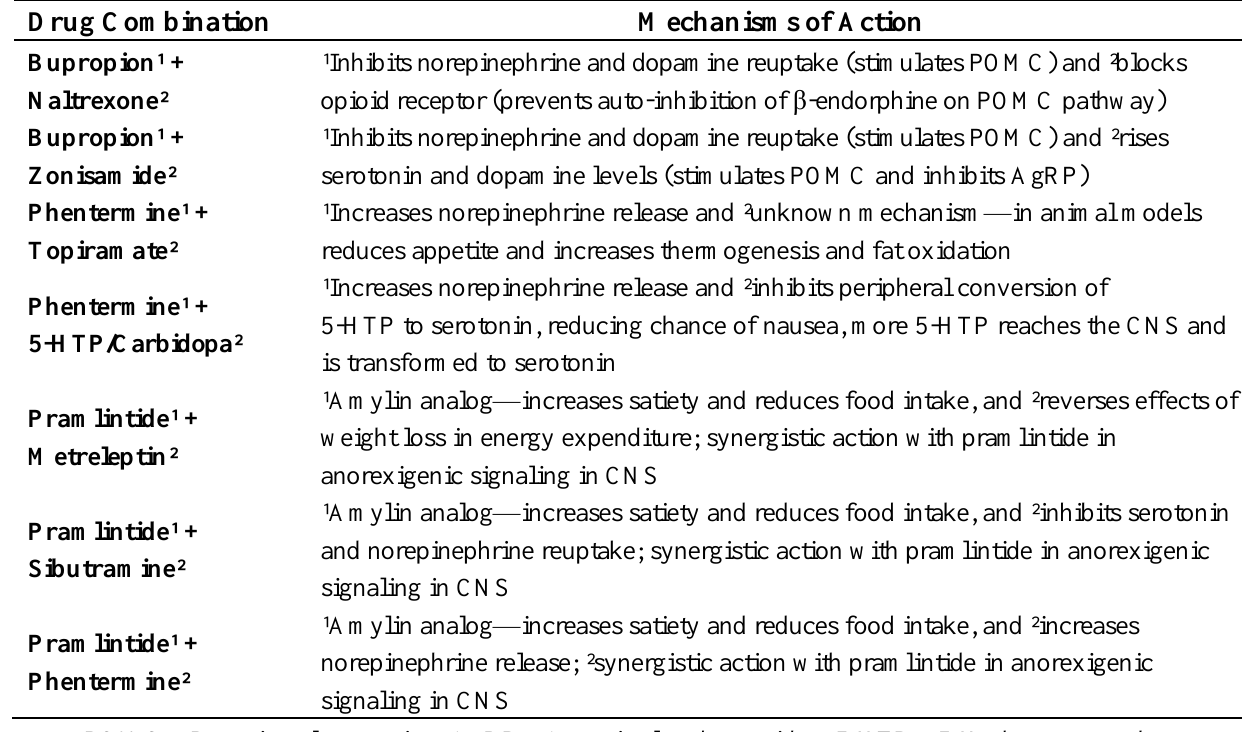
Table 1. Established mechanisms of action of combinations of drugs for the treatment of obesity. Drug Combination Mechanisms of Action